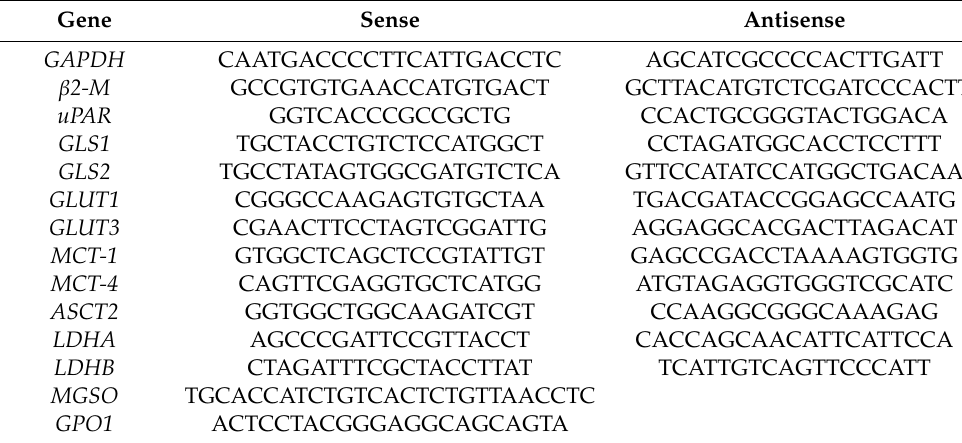
Table 2. List of all primers